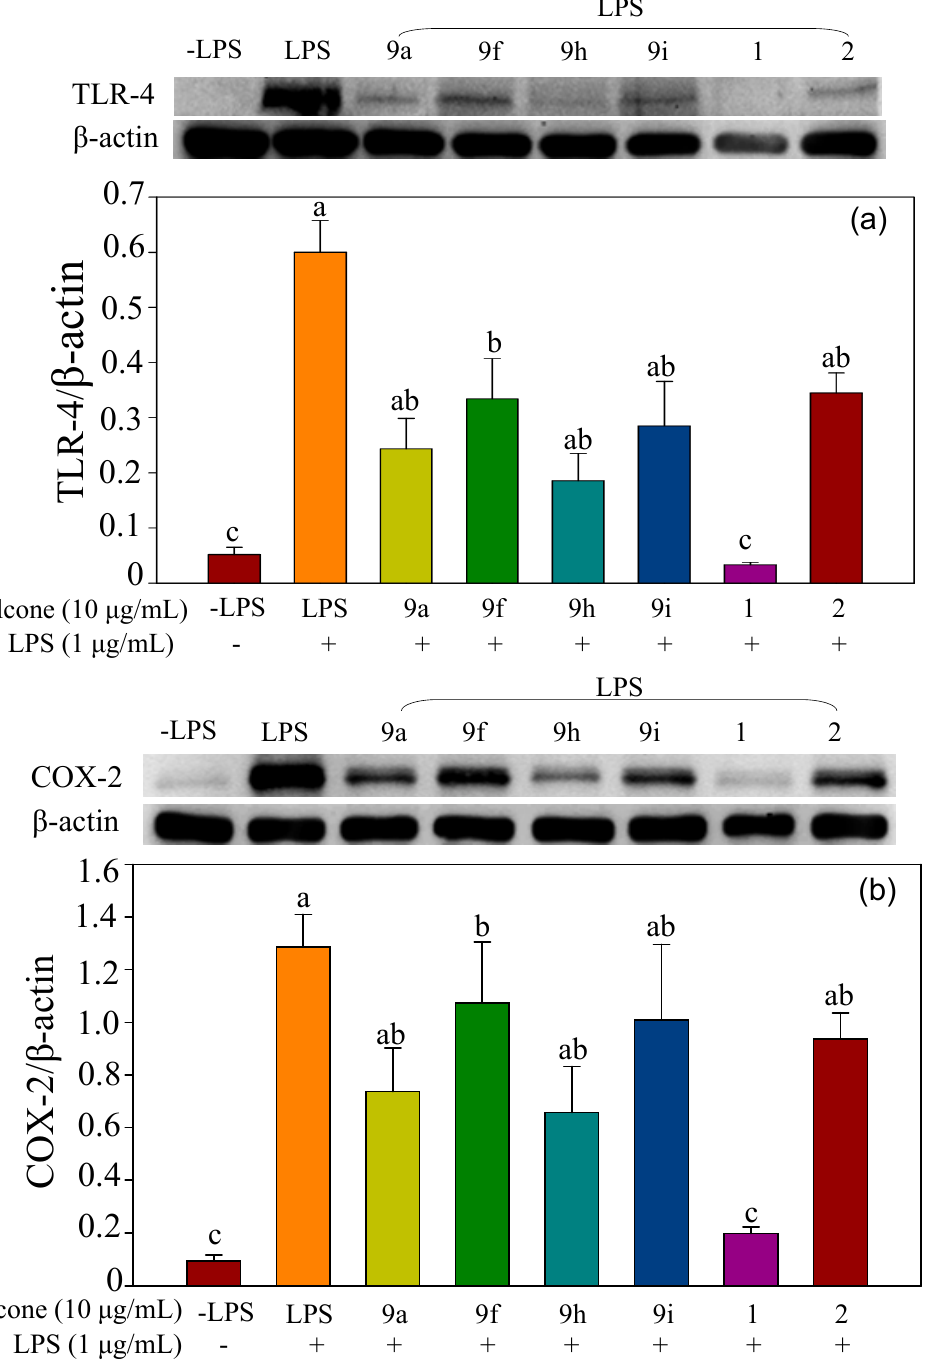
Figure 9. Protein expression of ( a ) TLR4 and ( b ) COX-2. RAW 264.7 cells were pre-treated with synthetic halo-substituted azachalcones 9a , 9f , 9h , 9i or natural synthetic compounds 1 or 2 (10 µ g/mL) for 1 h before induction of inflammation by LPS (1 µ g/mL) for 6 h. Values indicate means ± SD. Bars with the same letters are not significantly different ( α = 0.05). LPS: